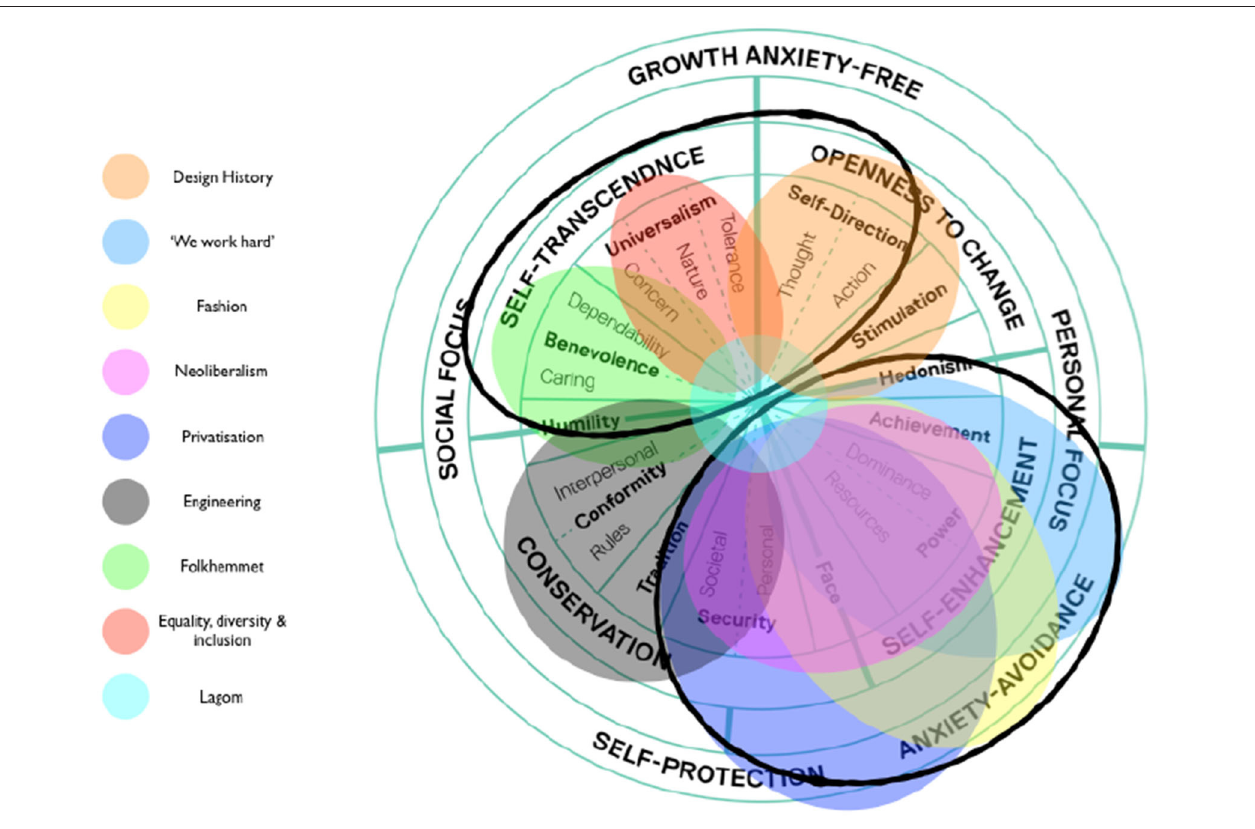
FIGURE 4 | An illustration of value-directedness of themes relating to Swedish national culture. Value-directedness weighted toward competition (bottom right) and away from collaboration (top left) at the level of Swedish national culture illustrated by emergent themes in the macro environment. Adapted from Schwartz et al.